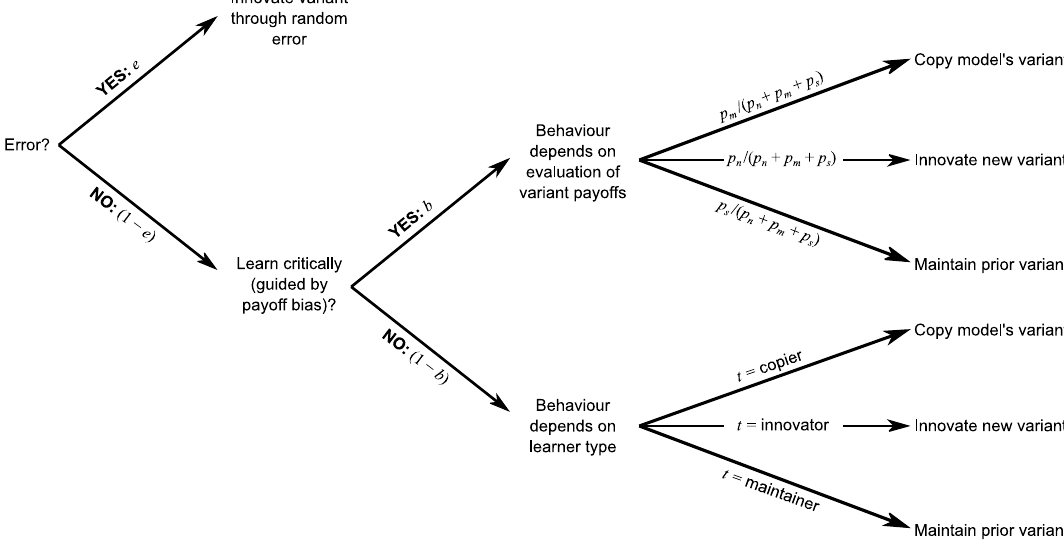
Figure 1. Diagram showing how the various parameters drove agents’ variant